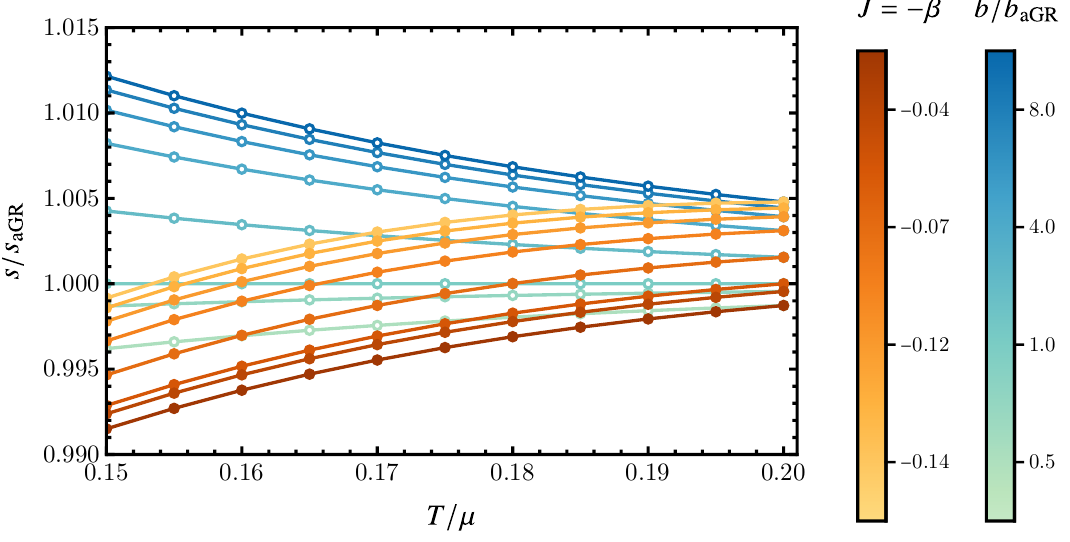
Figure 5 . Black hole entropy as a function of T/µ when keeping either the alternate quantization source J = − β fixed (choice 3, orange gradient curves) or when keeping the label b ( ψ (0)) fixed (choice 1, blue gradient curves). The curves meet in pairs at T/µ — indicating identical bulk solutions — and separate for other temperatures — indicating different black hole